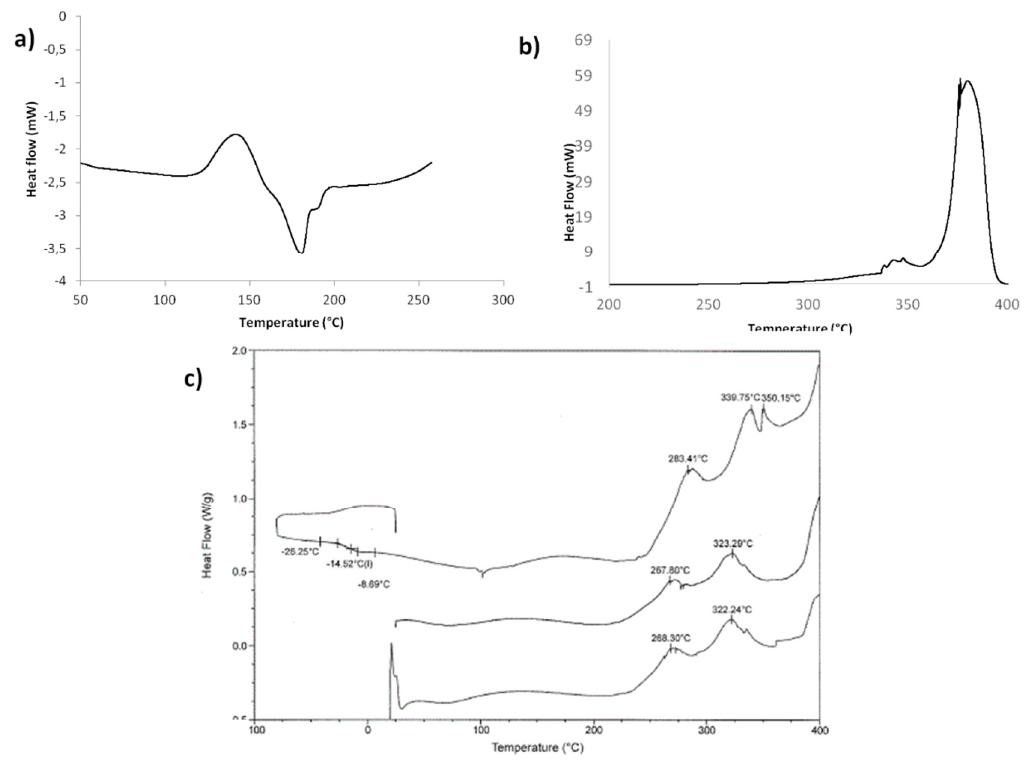
Figure 2. DSC thermograms of ( a ) PEF and ( b ) PHPF ( c ) PDGF after quenching their melted solution with liquid N 2 . Heating and cooling rate was 10 °C/min.